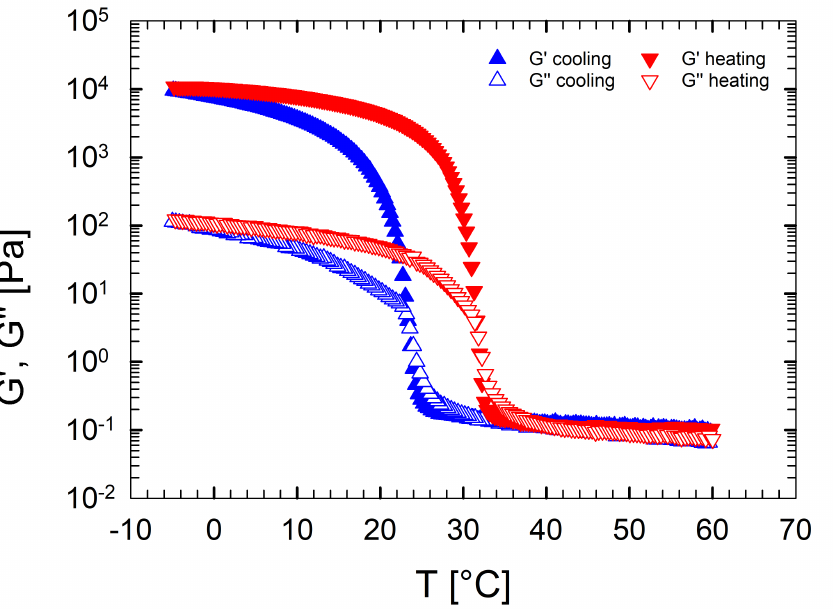
Figure 1. Storage modulus G (cid:48) and loss modulus G (cid:48)(cid:48) as functions of the temperature for an aqueous gelatin solution (Sol. 2) at 1 °C/min. Up-triangles indicate the cooling phase, down-triangles the heating